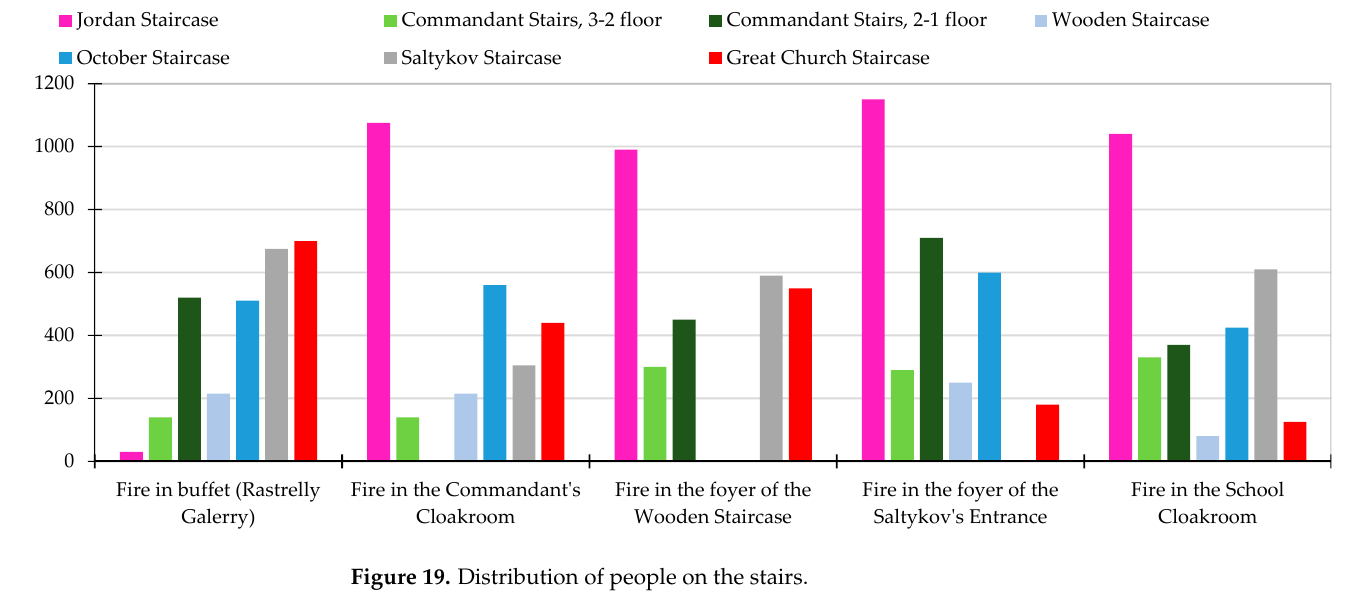
Figure 19. Distribution of people on the stairs.